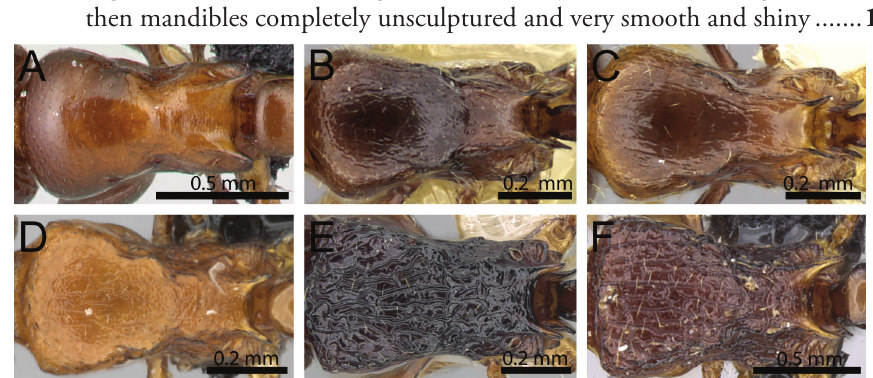
Figure 14. Mesosoma in dorsal view. A T. wardi (CASENT0475483) B T. tyrion (CASENT0249085) C T. tsingy (CASENT0426807) D T. freya (CASENT0466944) E T. camelliae (CASENT0247496) F T. dalek